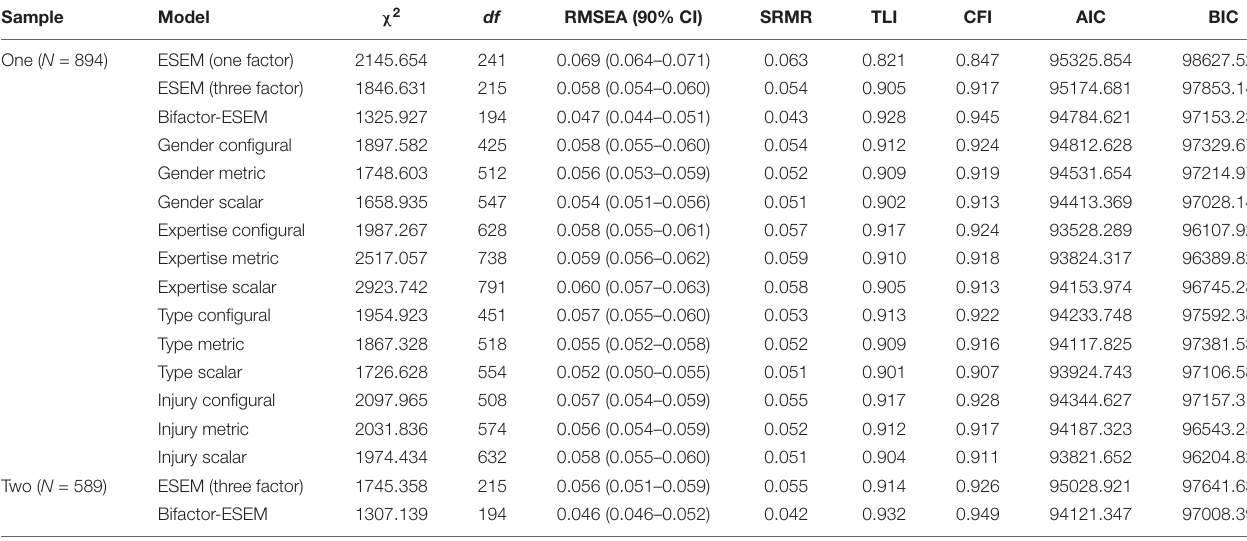
TABLE 2 | Model fit indices for sample one and two.